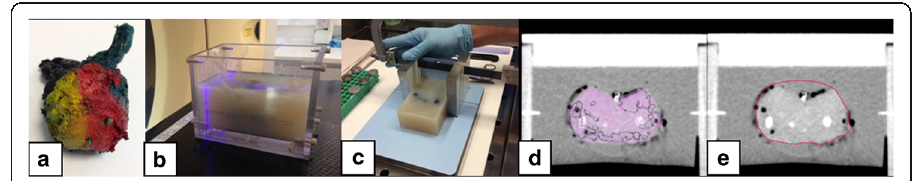
Fig. 1 Histopathological preparation and ex vivo CT scans. a Resected prostate marked with special ink for later orientation. b Prostate embedded in agarose inside a special localizer box. c Cutting at defined marker positions. d Overlay of ex vivo CT with histopathological information ( pink ) including tumor definition ( black lines). e Ex vivo CT with contours for